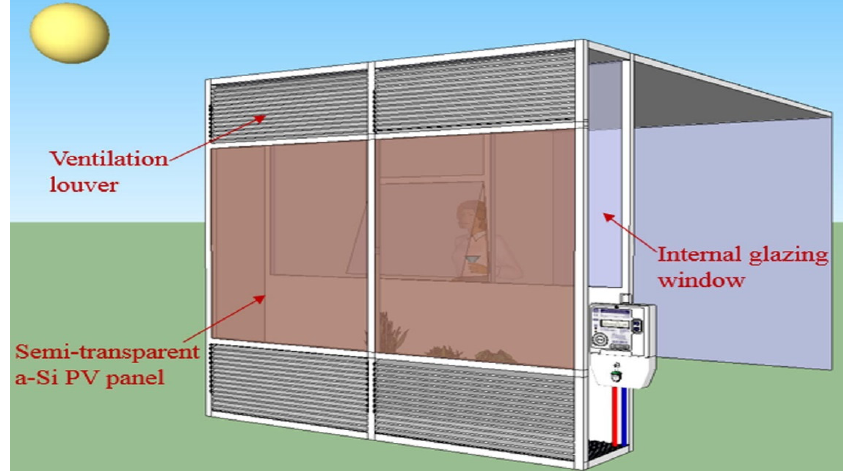
Figure 8. Schematic of the suggested photovoltaic with double-skin facade (PV-DSF). Reproduced with permission from ref. [116]. Copyright 2016 Elsevier.